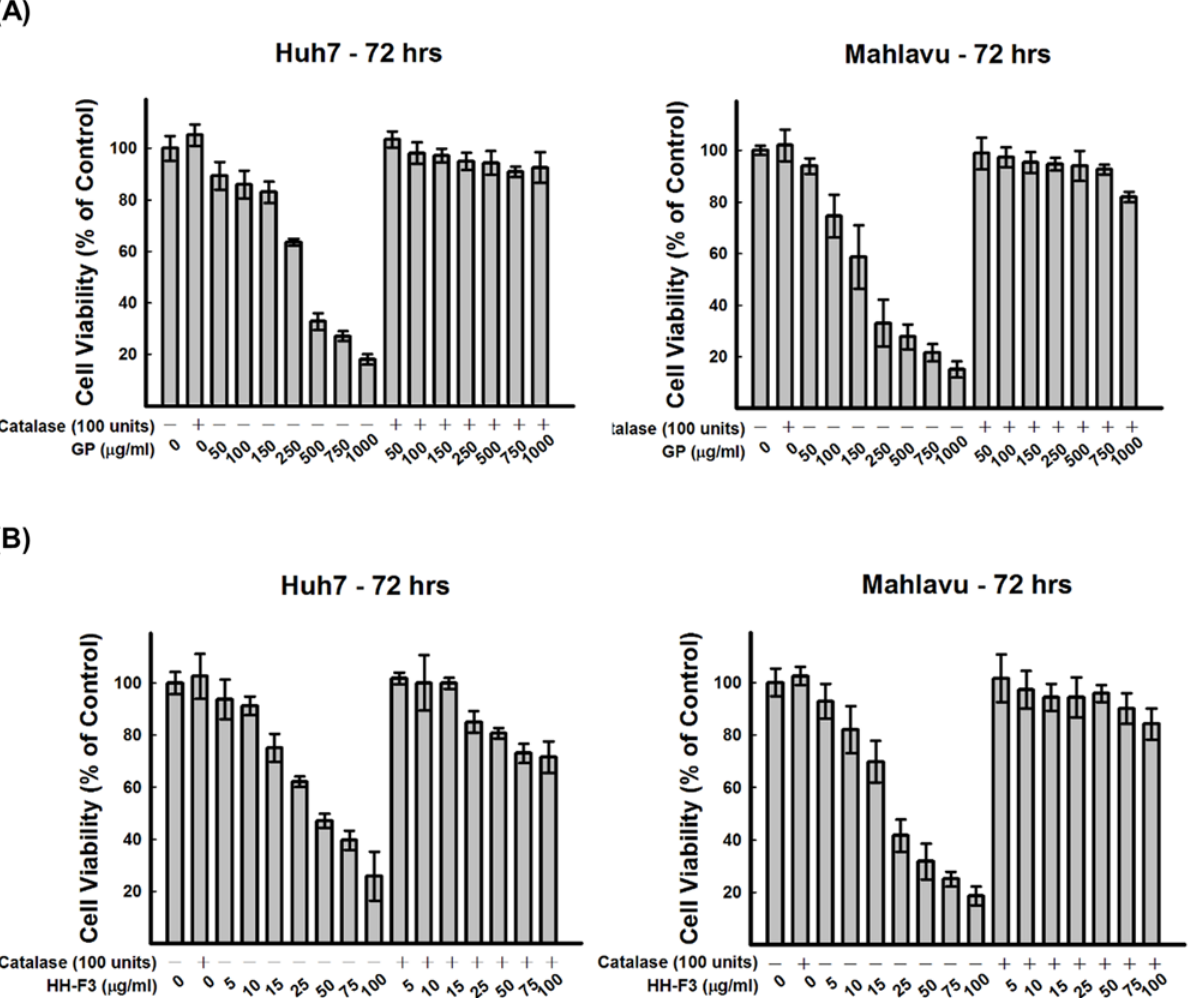
Fig 4. Pretreatment with catalase blocks 30% DMSO GP extracts- or HH-F3-induced cytotoxicity in HCC cells. Huh7 and Mahlavu cells were pretreated with catalase (100 U/ml) for 30 min and exposed to (A) 30% DMSO GP extracts or (B) HH-F3 for 72 hrs. Cell viability was evaluated with the MTT assay. The results were expressed as the optical density percentage relative to the control (n =